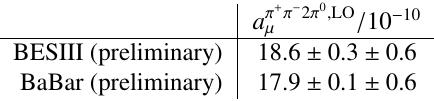
+ π − 2 π 0 , LO µ from BaBar and